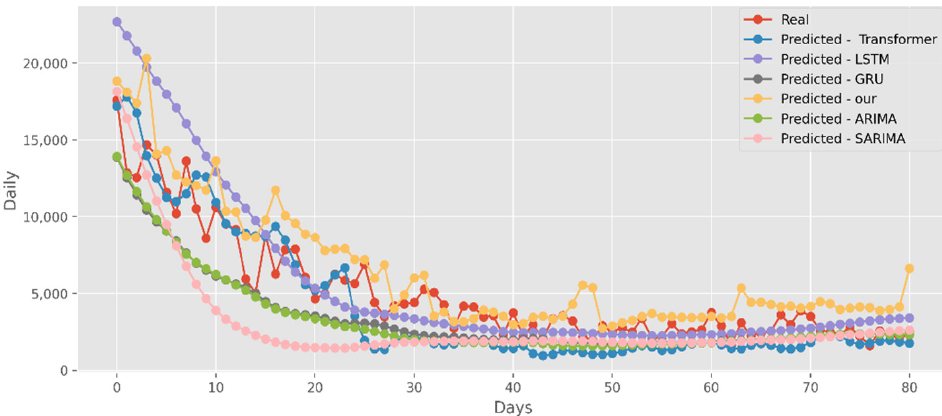
Figure 12. Comparison of COVID-19 prediction models of cases in CA.